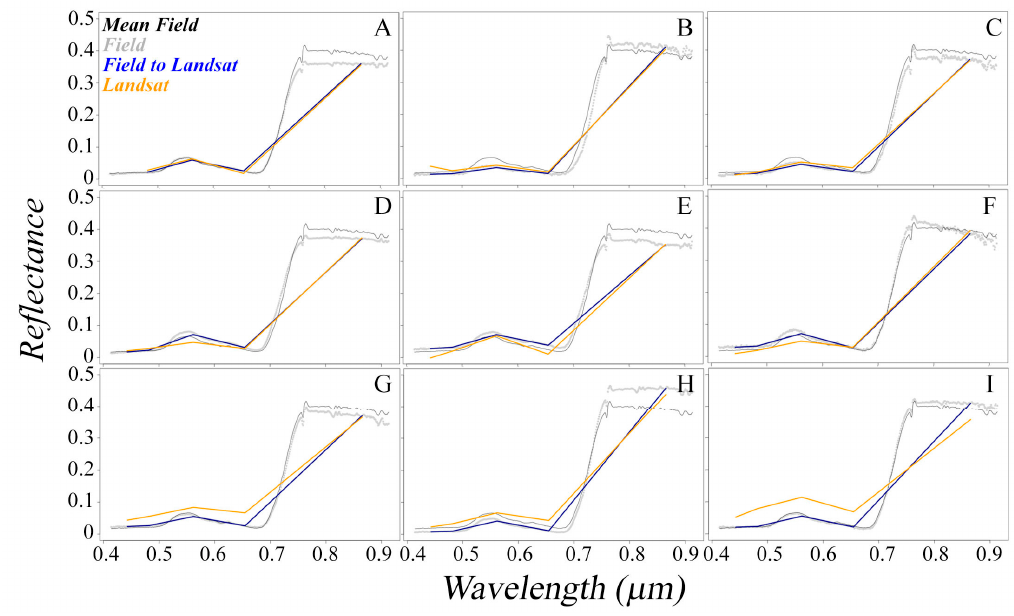
Figure A1 . Comparison of field and satellite spectra. Continuous field spectra (light gray) were collected on July 28 and 29 at 9 rice fields, then convolved to bands 2-5 of the Landsat 8 OLI sensor (blue). These are then compared with actual Landsat spectra from the same locations imaged on August 4 (gold). The Landsat spectra were atmospherically corrected with the standard LaSRC atmospheric correction. In some cases (A-C) the synthetic and observed Landsat spectra agree remarkably well, especially given the pervasive atmospheric effects due to fires present during both the days of field measurement and satellite overpass and the nearly 1 week of time elapsed. In other cases (D-F), the overall ranges of the spectra are similar but the shape in the visible is notably distorted. In yet other cases (G-I), loss of contrast is observed, likely due to aerosol contamination incompletely corrected by the LaSRC model. Locations of field spectra are shown in Figure 7.